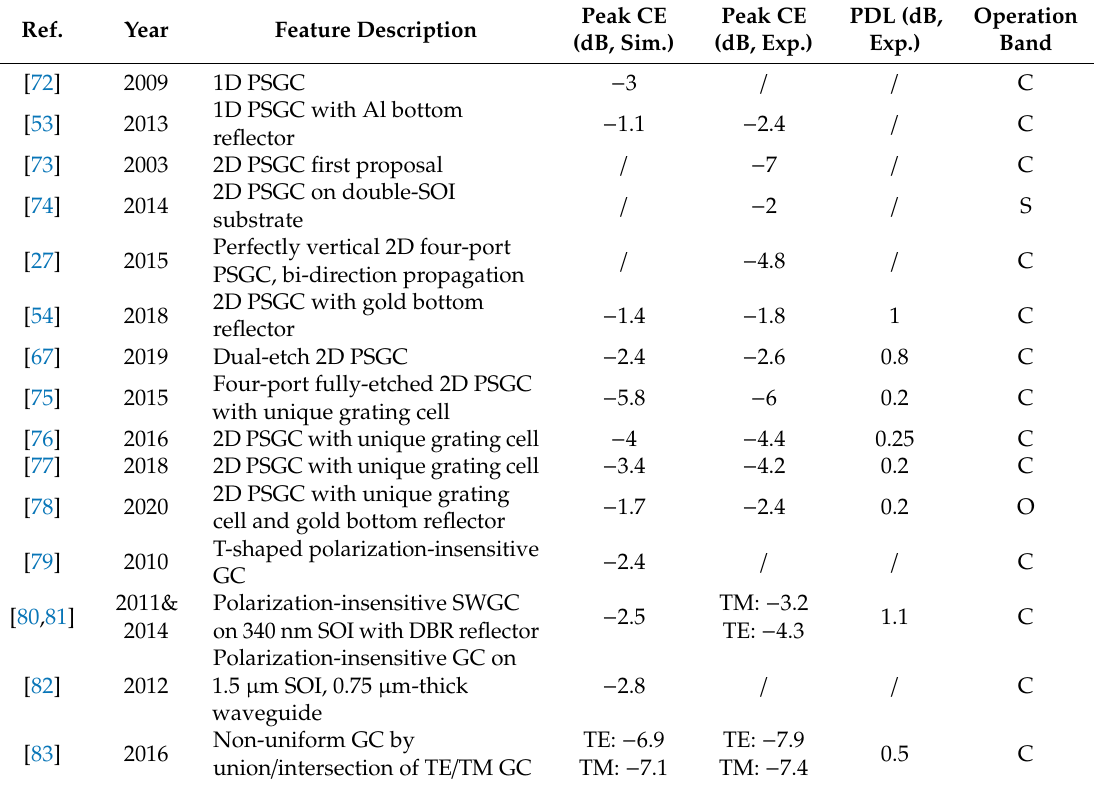
Table 2. Comparison of polarization diversity in GCs reviewed in Section 4.1.